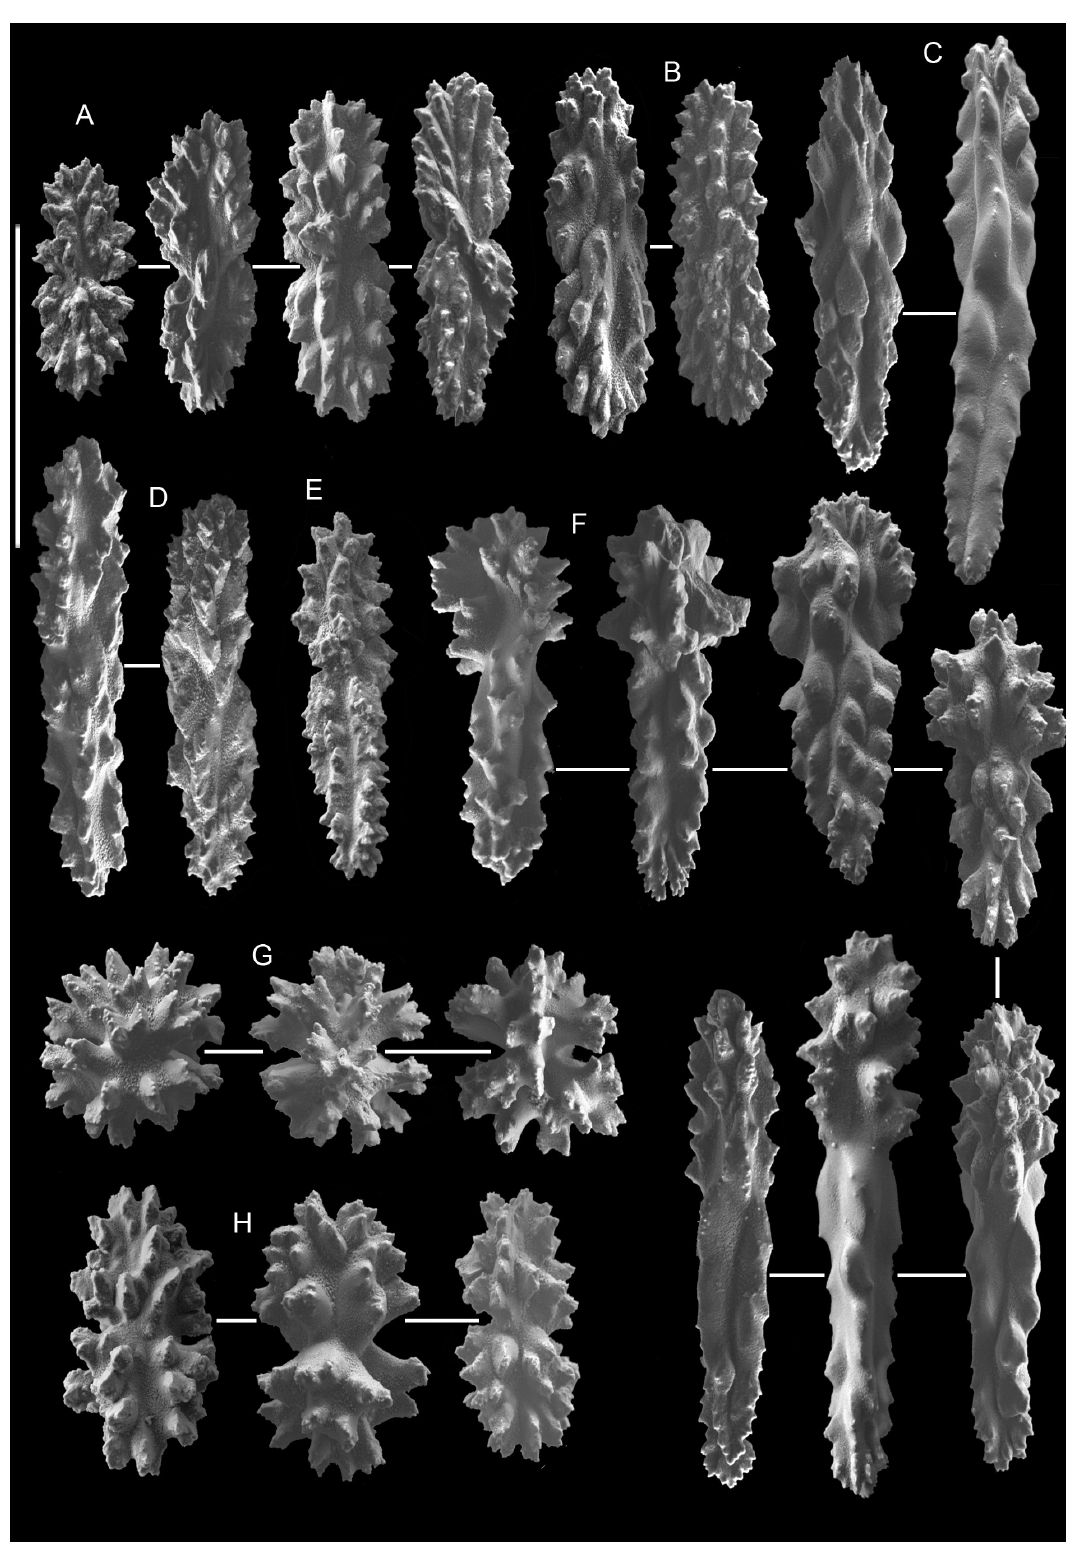
Fig. 2. Heteropolypus annae sp. nov., holotype (MIMB 42493); sclerites from the autozooid tentacles. A . Waisted plates. B . Plates. C . Flanged spindles. D . Warty spindles. E . Club-like spindle. F . Clubs. G . Capstans. H . Slender capstans. Scale bar = 0.1